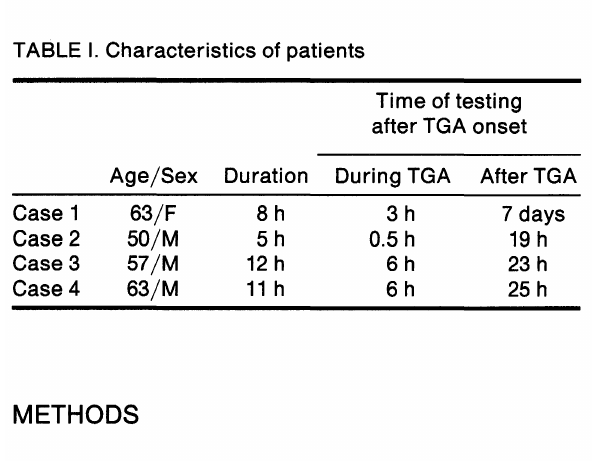
TABLE I. Characteristics of patients